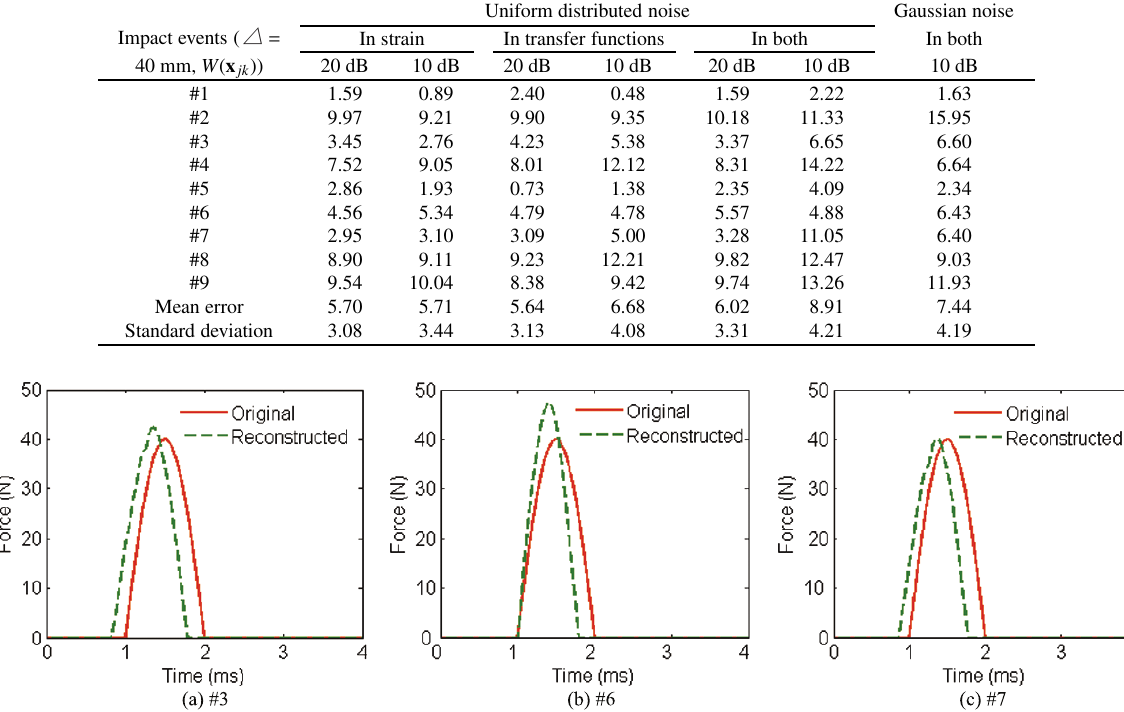
Fig. 7. Impact force time-history